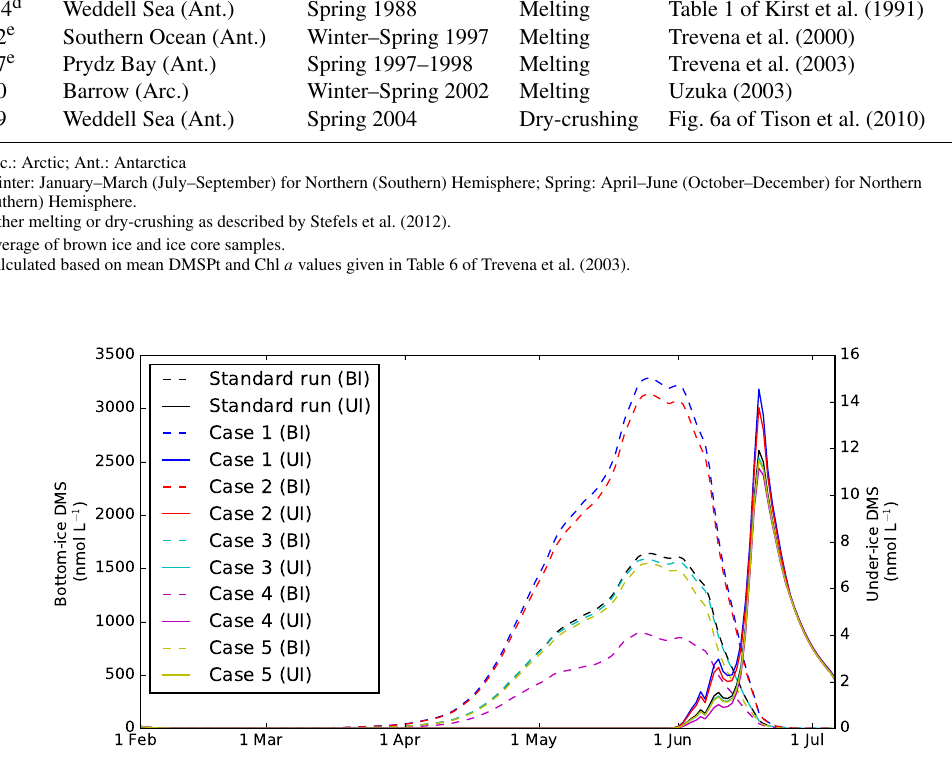
Table 1 of Kirst et al. (1991)